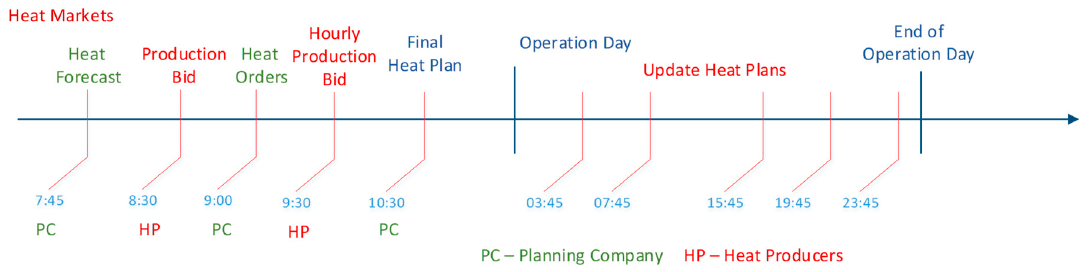
Figure 3. Typical generation process of heat plans in district heating based on [19].